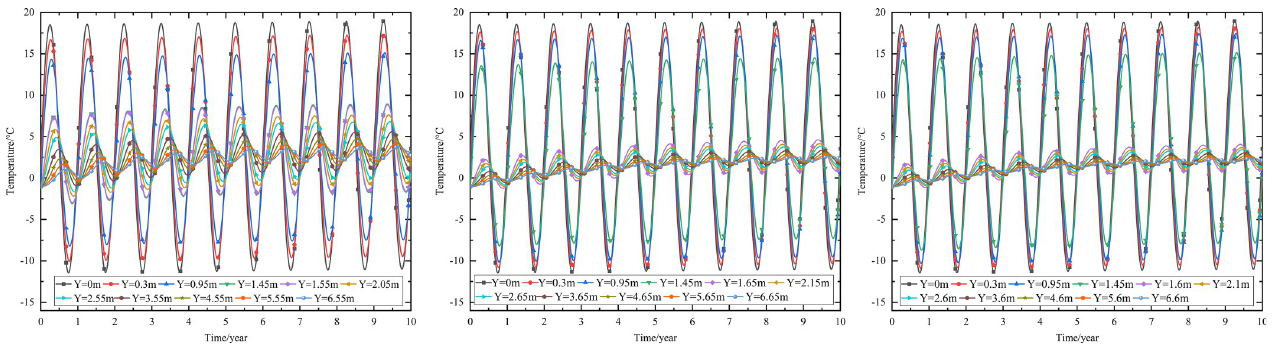
Fig 9. Temperature-time curves of pavement center at the installation layer thickness of (a) 0.10 m, (b) 0.15 m, and (c) 0.20 m.